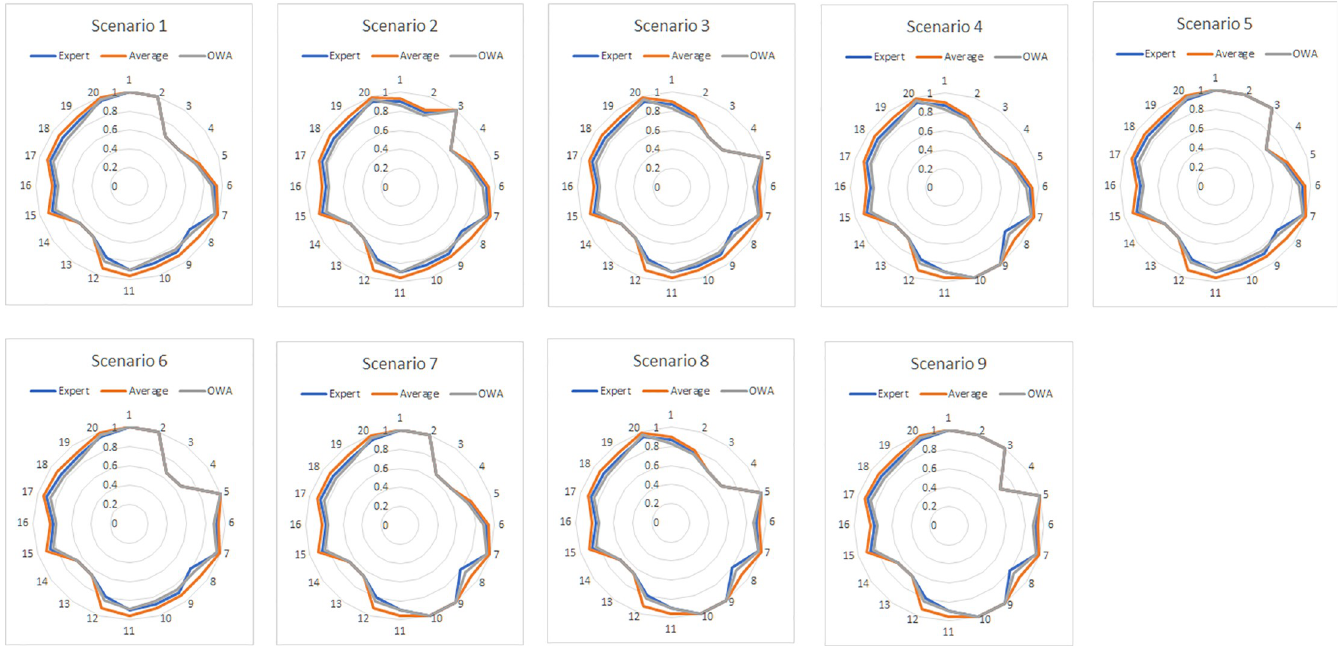
Fig 8. Spider graphs for the Expert-based, Average, and OWA-FCMs (L).